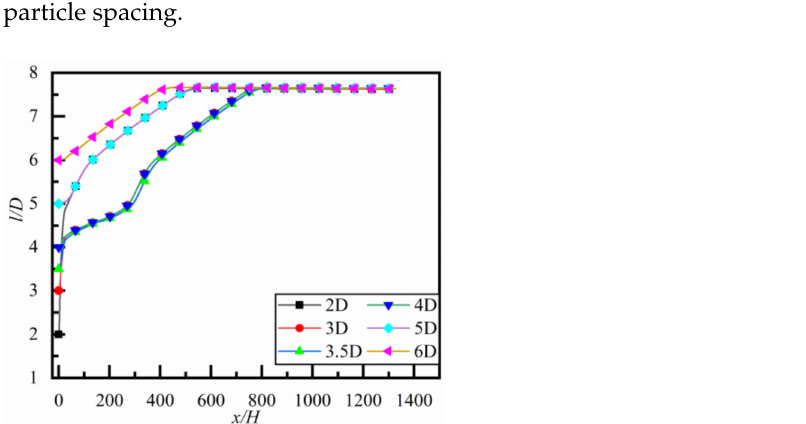
Figure 6. Changes of inter-particle spacing along the flow direction for a single-scale particle pair ( k = 0.4, Re = 20).